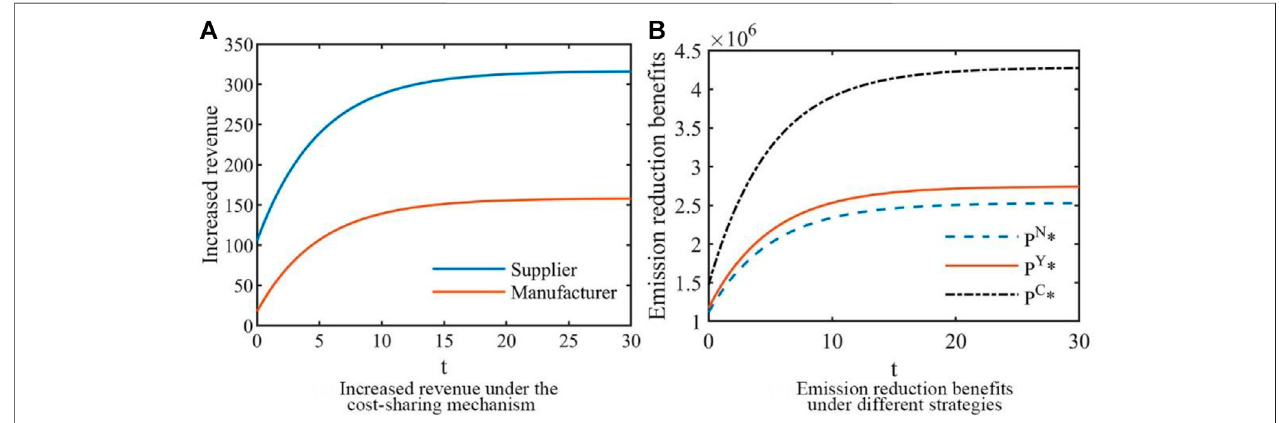
FIGURE 1 | Carbon emission reduction bene fi ts under different KS strategies. (A) Increased revenue under the cost-sharing mechanism. (B) Emission reduction bene fi ts under different strategies.